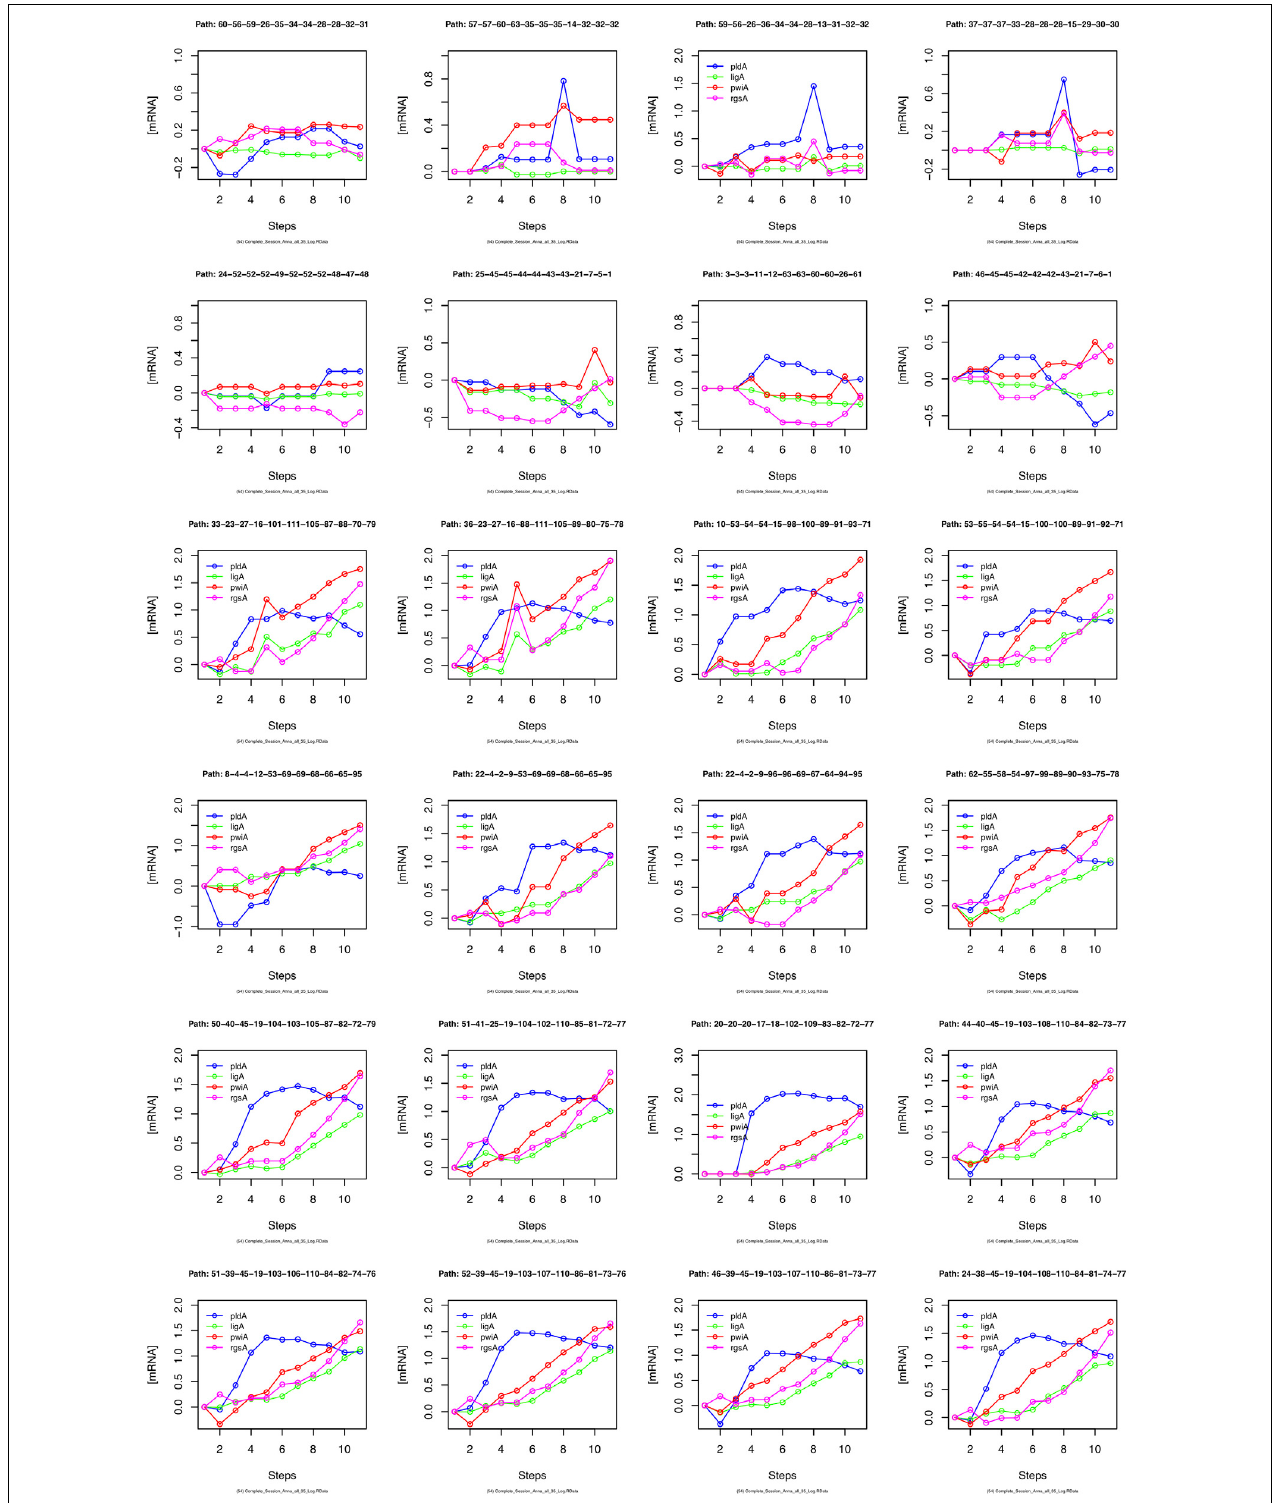
FIGURE 9 | Gene expression kinetics as derived from single cell trajectories. Each panel represents the trajectory of one single cell as characterized by subsequent states of expression of the same, arbitrarily chosen set of genes. For each gene, the logarithm to the base 10 of the geometric mean of the expression values of each cluster was plotted against time. Plotting the geometric mean instead of individual expression values results in discretization of the data while comparing different trajectories.